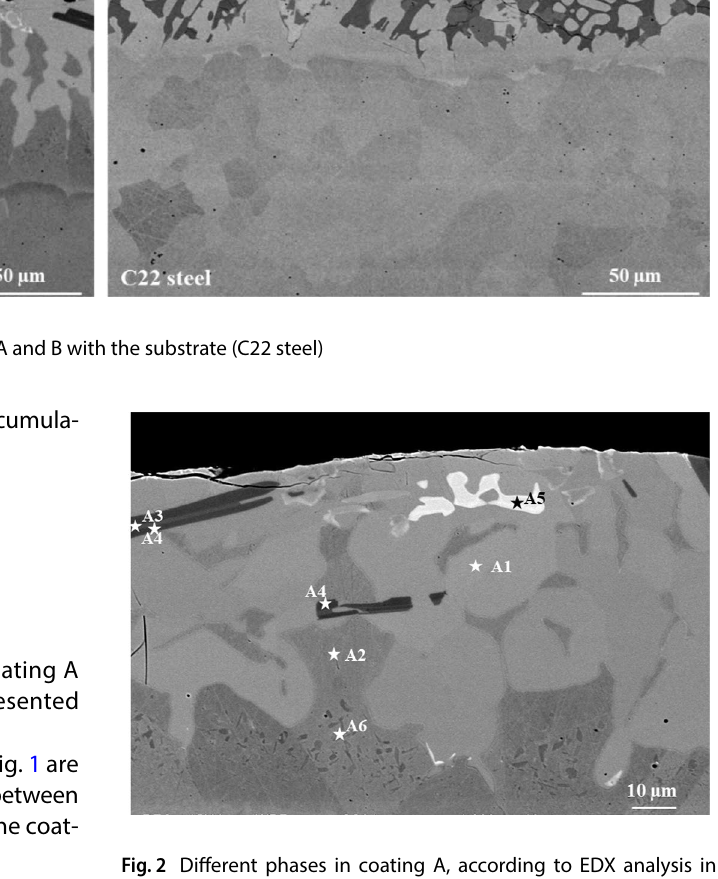
Fig. 2 Different phases in coating A, according to EDX analysis in Table 3